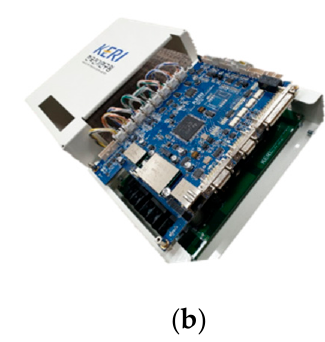
Figure 7. Overall linear generator assembly components and final prototype: ( a ) stator assembly; ( b ) mover assembly; ( c ) final prototype.